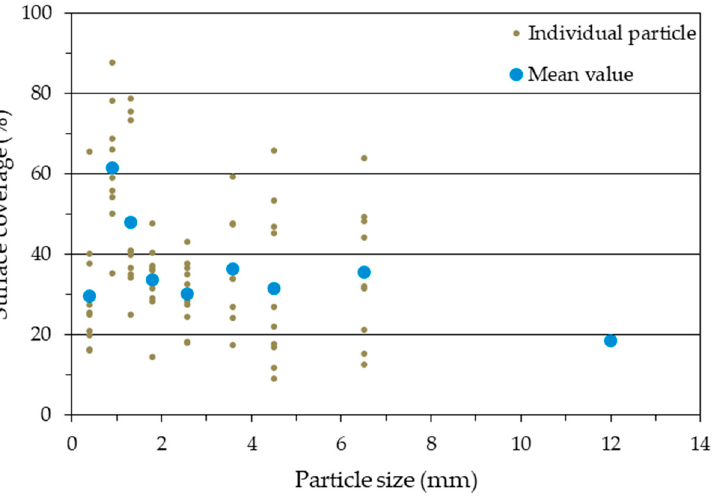
Figure 12. Mean and individual values of the surface coverage of individual particles from PM 3 (AC 19%).